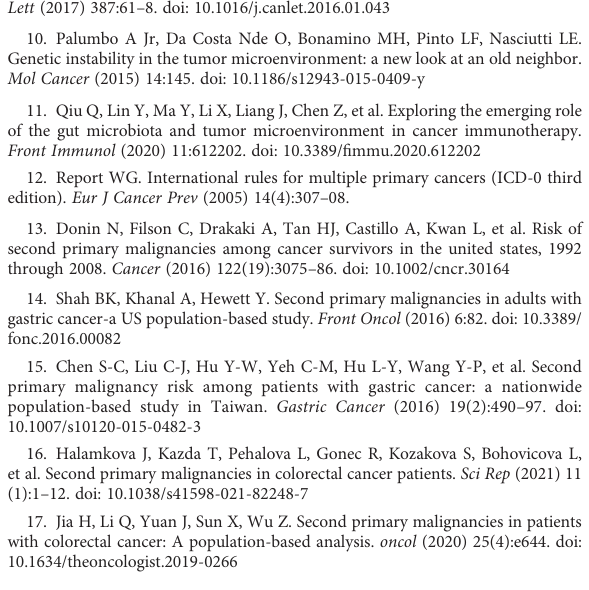
SUPPLEMENTARY FIGURE 1 Mutational pro fi les of GC and CRC. (A) : Oncoplot showed the somatic mutations in each of the CRC and GC sites. The top bar showed the counts of alterations type in each sample. The left annotation indicated the functions of the genes. The right bar showed the counts of alterations type of each gene. (B) : Mutations detected in more than one of the CRC and GC sites were clustered